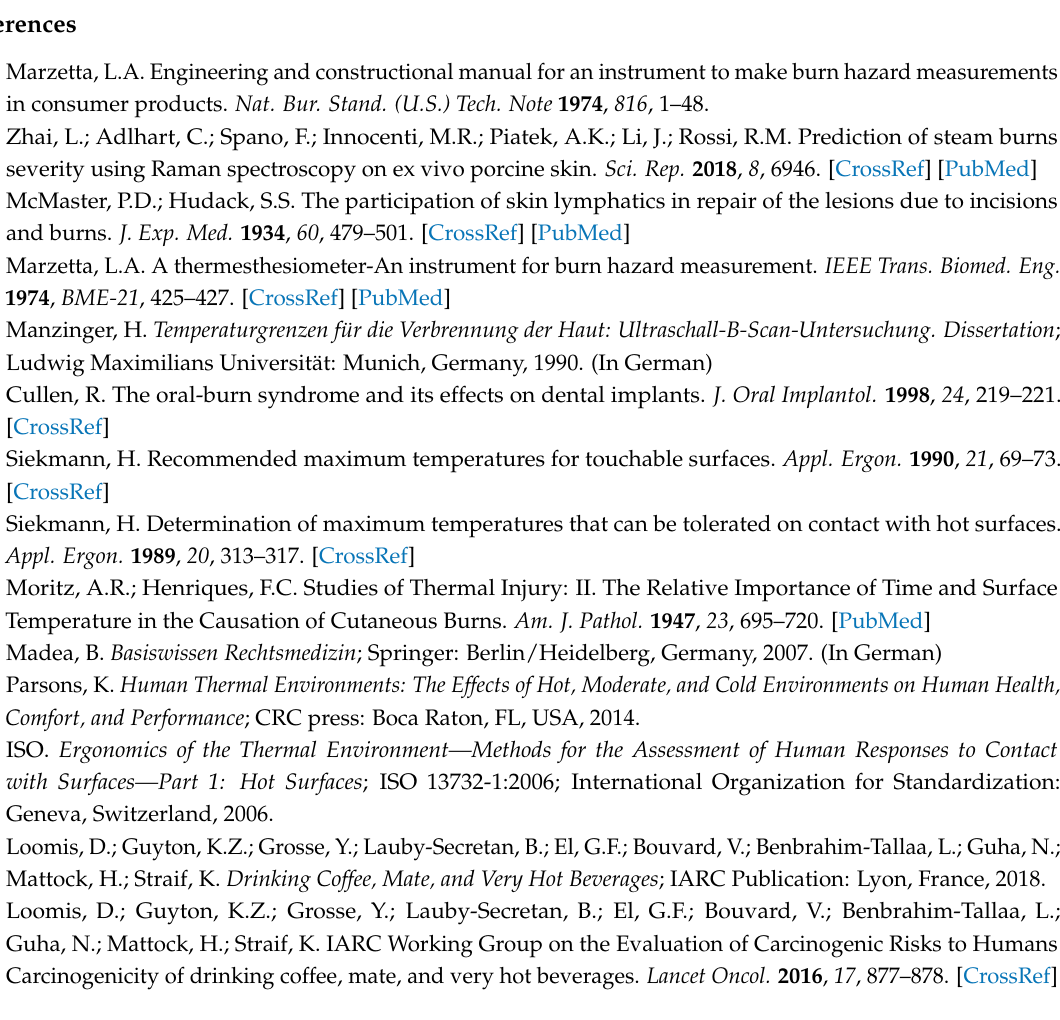
Supplementary Materials: The following are available online at http://www.mdpi.com/2313-576X/4/3/38/s1, Tables S1 and S2: Calculation table for numerical simulation of contact temperatures in Microsoft Excel format (S1: English version, S2: German